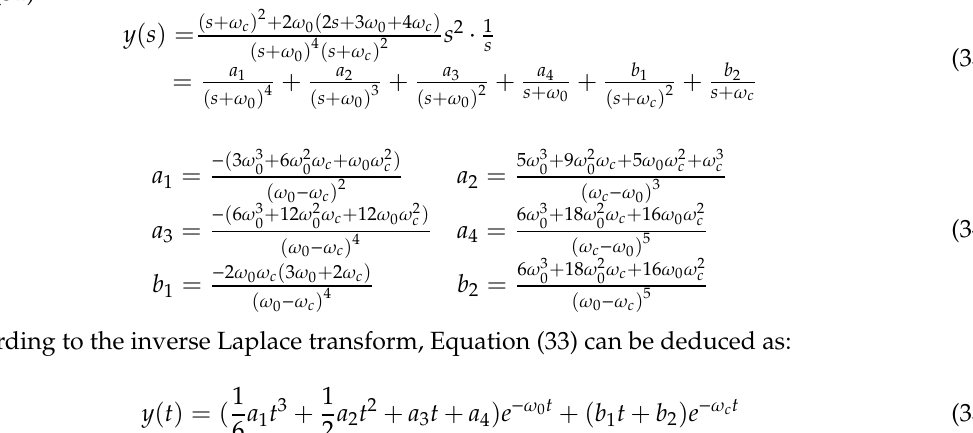
Figure 12. Frequency domain characteristic curve of perturbation transfer function (when ω c changing).